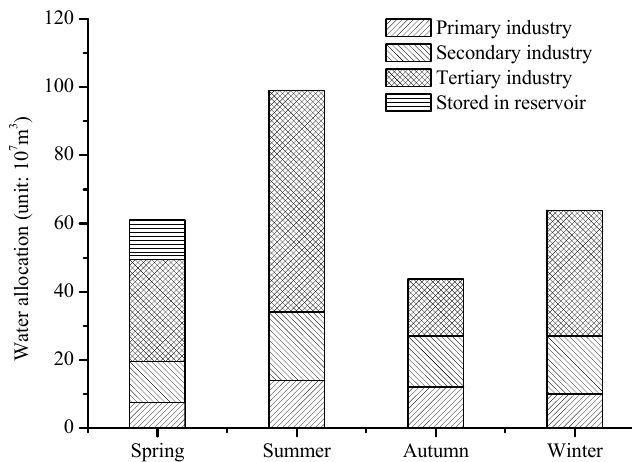
Figure 7. The allocation results of water sources and the quantity stored in reservoirs under violating constraint α = 0.05.